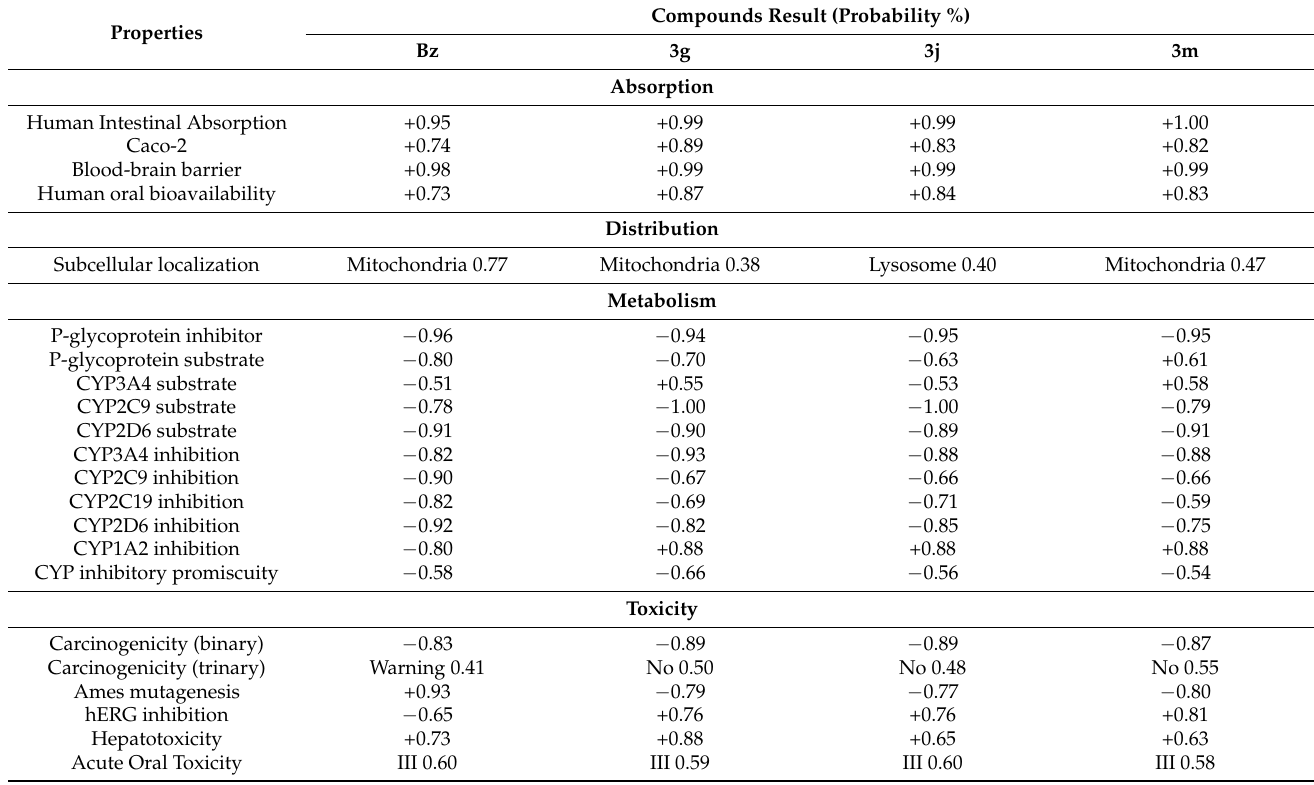
Table 3. In silico prediction of ADMET